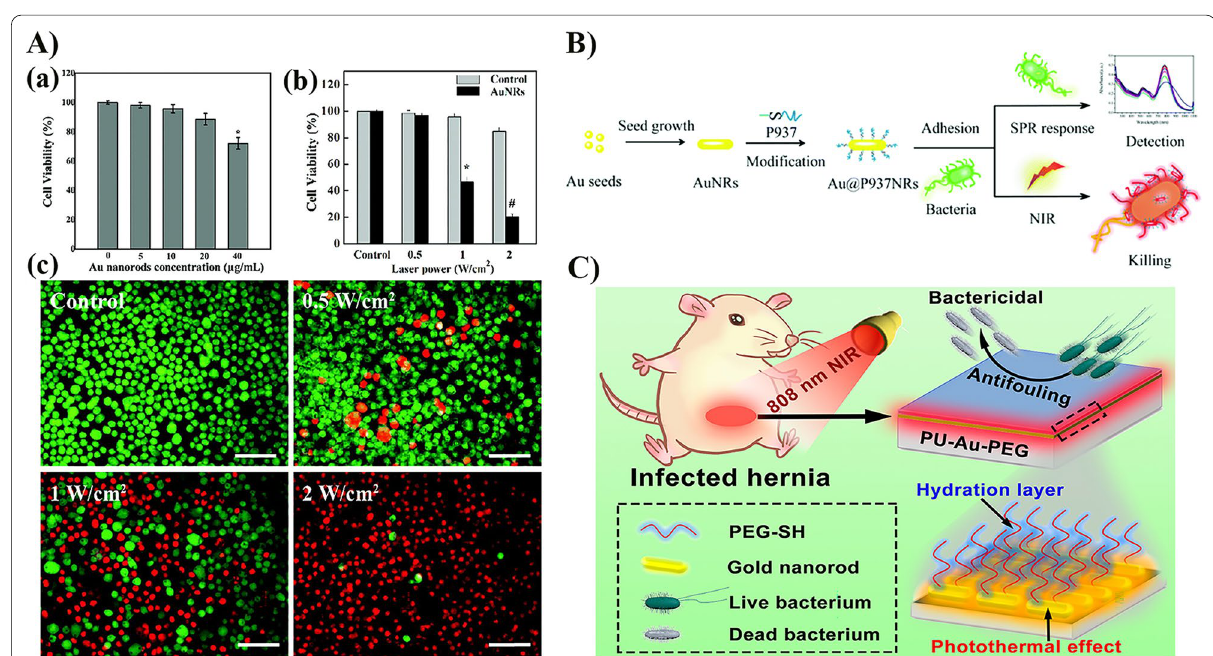
Fig. 5 AuNRs photothermal treatment of inflammatory diseases; killing bacteria and viruses. A Cytotoxicity of AuNRs and PTT. (a) In vitro cell viability of Ana-1 cells, a mouse macrophage cell line, treated with or without various concentrations of the AuNRs for 24 h. (b) Cell viability of Ana-1 cells treated with or without the AuNRs (20 μg mL − 1 ) after the NIR laser irradiation with different power densities (0, 0.5, 1, and 2 W cm − 2 ). (c) Live cells and dead cells were stained with calcein AM (green) and PI (red), after incubation of Ana-1 cells with or without the AuNRs (20 μg mL − 1 ) and being exposed to an 808 nm laser at different power densities (0.5, 1, and 2 W cm − 2 ). Scale bar: 100 μm. Reproduced with permission from